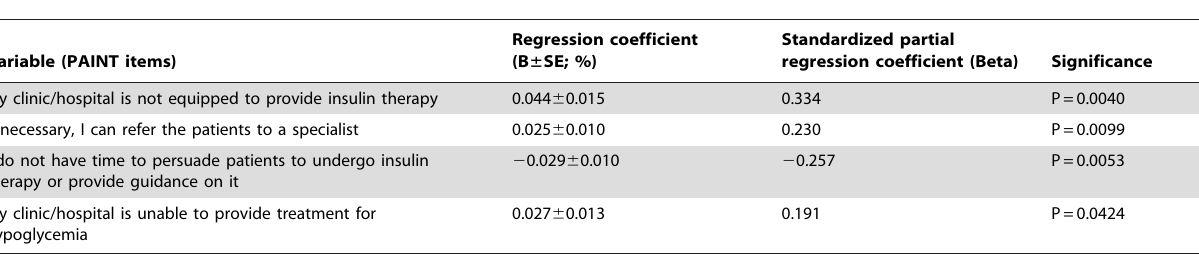
Table 3. Stepwise multiple linear regression analysis of the PAINT items associated with the rate of insulin use.